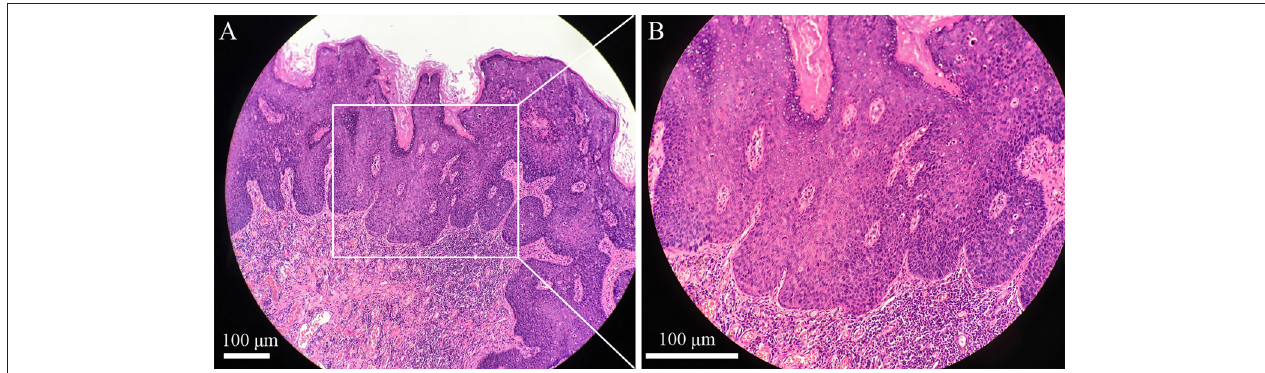
FIGURE 2 | Pathological image of the penile intraepithelial neoplasia lesion with H&E staining, original amplification × 100, scale bar 100 µ m (A) . Pathological image of the penile intraepithelial neoplasia lesion with H&E staining, original amplification × 200, scale bar 100 µ m (B)